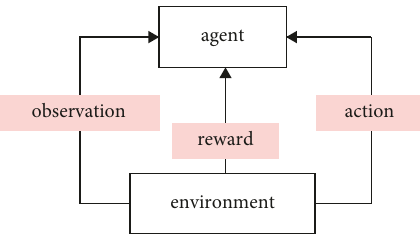
Figure 2: The framework of reinforcement